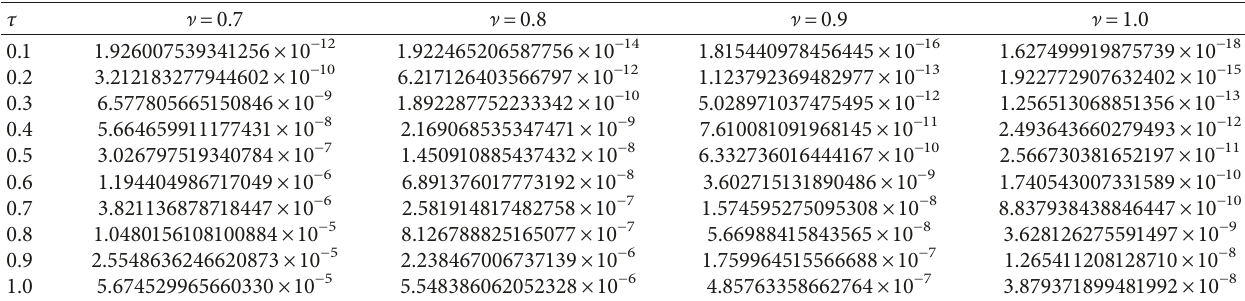
Table 8: The recurrence error of the 5th approximate solution of the imaginary part in Example 2.